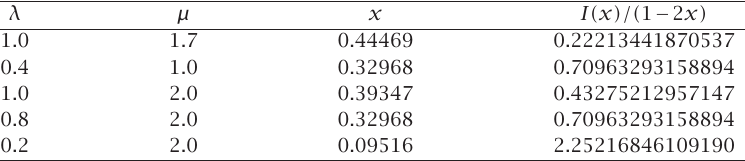
Figure 6.1 . Behaviour of I(x)/(r − x(r − r r = 1, and varying values of λ and µ . Table 6.1 . Value of x at which I(x)/( 1 − 2 x) attains the minimum and the corresponding minimum for different values of λ and µ .